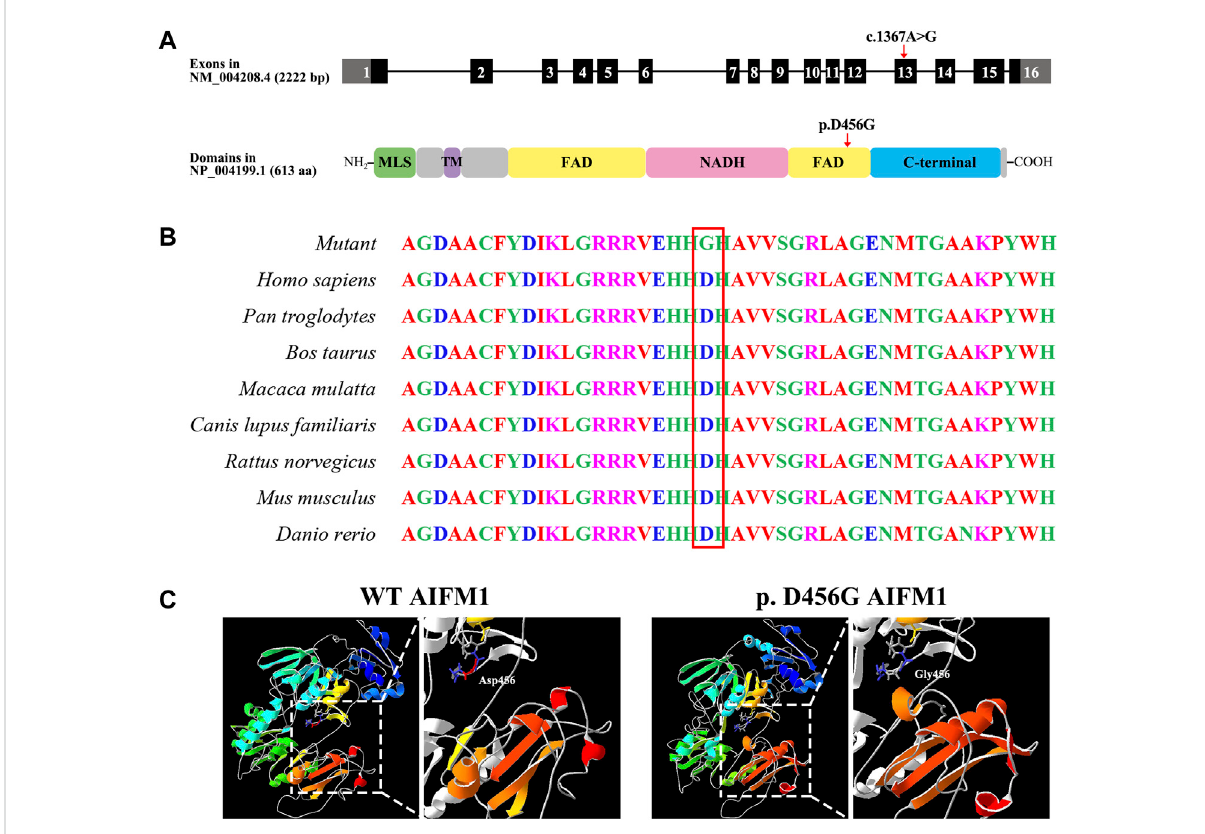
FIGURE 3 Molecular characteristics of AIFM1 variant. (A) Genomic and protein structures showing the locations of AIFM1 variant in exon 13 and the FAD domain indicated by the red arrows. The mutation c.1367A > G causes the replacement of individual amino acids (p. D456G) indicated by the red arrow. MLS: Mitochondrial Localization Signal; TM: Transmembrane domain; FAD: Flavin Adenine Dinucleotide; NADH: Nicotinamide Adenine Dinucleotide. (B) AIFM1 proteinalignmentofeightspeciesofvertebratesshowingthattheAspartic(Asp,D)locatedin456highlightedinredbox is evolutionarily highly conserved. (C) 3D molecular models of the WT and p. D456G AIFM1